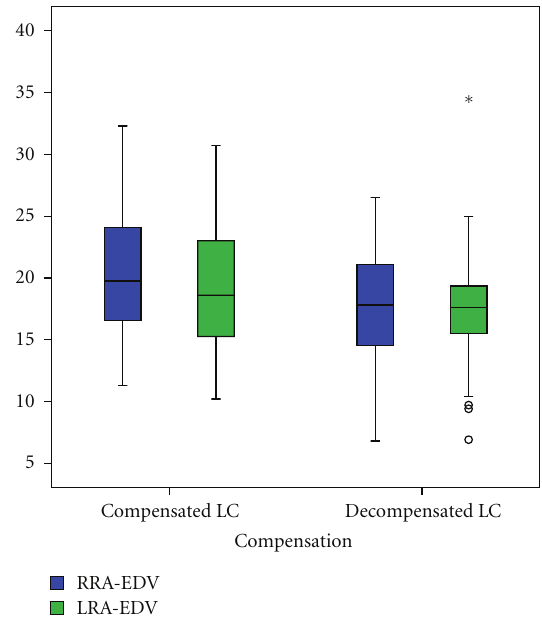
Figure 2: The values of RRA/LRA-EDV in patients with compen- sated and decompensated liver cirrhosis.